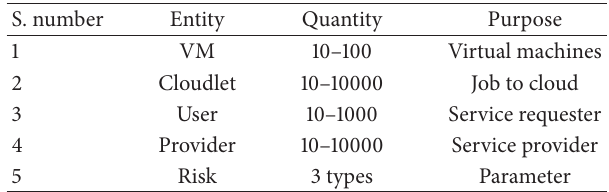
Table 2: Table 1 with values after risk calculation. Table 3: Test